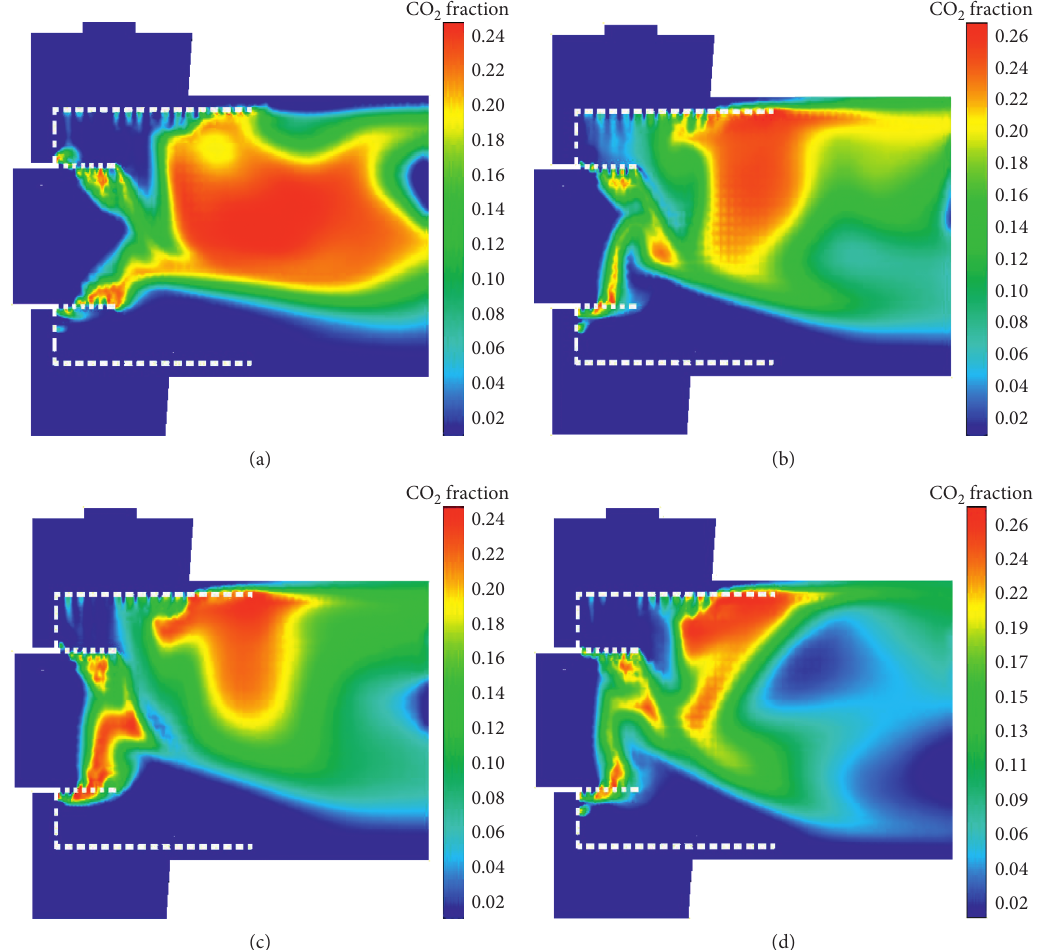
Figure 10: Longitudinal distribution of the CO α � 1.4. (c) α � 1.8. (d) α � 2.2.